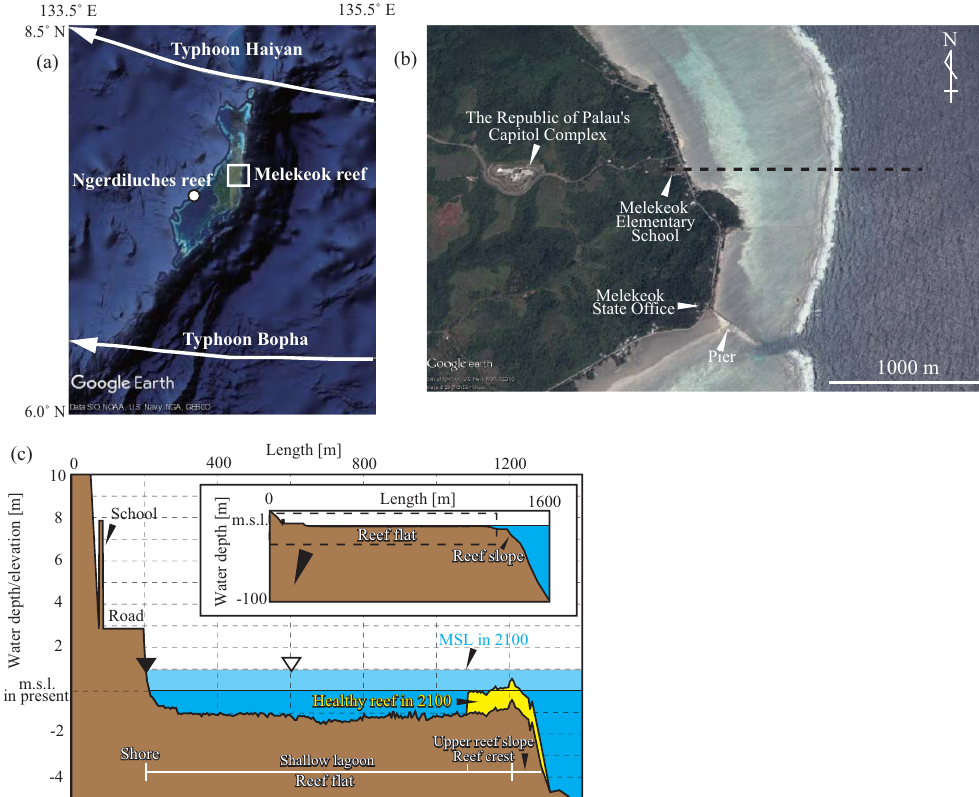
Figure 1. Location of Melekeok reef off the Palau Islands and the reef topography used for wave calculations. (a) Location of Melekeok reef. The open circle indicates the drill core site on Ngerdiluches reef (Kayanne et al., 2002). Typhoon Bopha passed south of Palau Islands on 2 December 2012 and Typhoon Haiyan passed north of the islands on 6–7 November 2013 (provided by Digital Typhoon, http://agora.ex. nii.ac.jp/digital-typhoon/index.html.en). (b) Satellite image of the reefs, long beaches, the Republic of Palau’s Capitol Complex, Melekeok elementary school, and Melekeok state office. The dashed line shows the location of the survey transect. (c) The measured cross section, showing the present-day and the 2100 reef topography. The reef crest and upper reef slope will be characterized by upward reef growth or cessation of growth in response to sea level rise (SLR). This figure shows the example of upward reef growth for a healthy reef in response to + 0.98m SLR in 2100, based on the Representative Concentration Pathway (RCP) 8.5 scenario (Church et al., 2013). The open and solid triangles indicate the locations used for calculating the significant wave height at the reef flat (SWH r ) (400m from the shore) and the water level at the shore (WL s ) , respectively. m.s.l. indicates mean sea